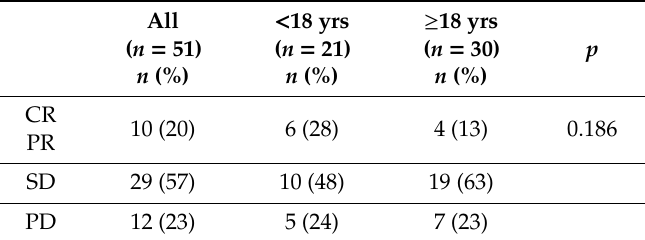
Table 3. Responses by RECIST 1.1 and age group in patients treated with high-dose